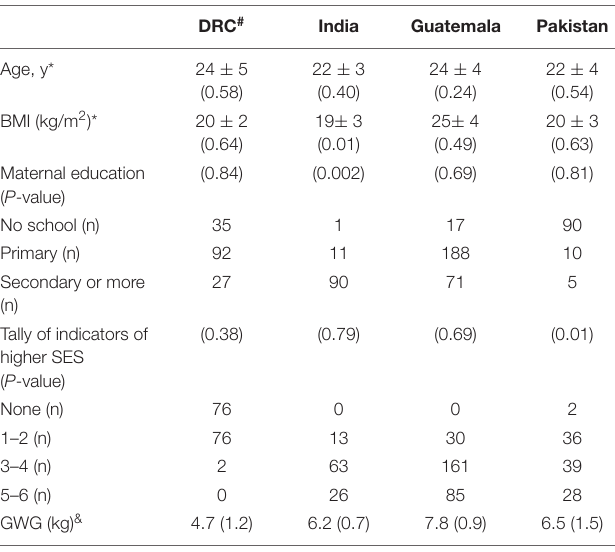
TABLE 3 | Participants’ baseline characteristics by